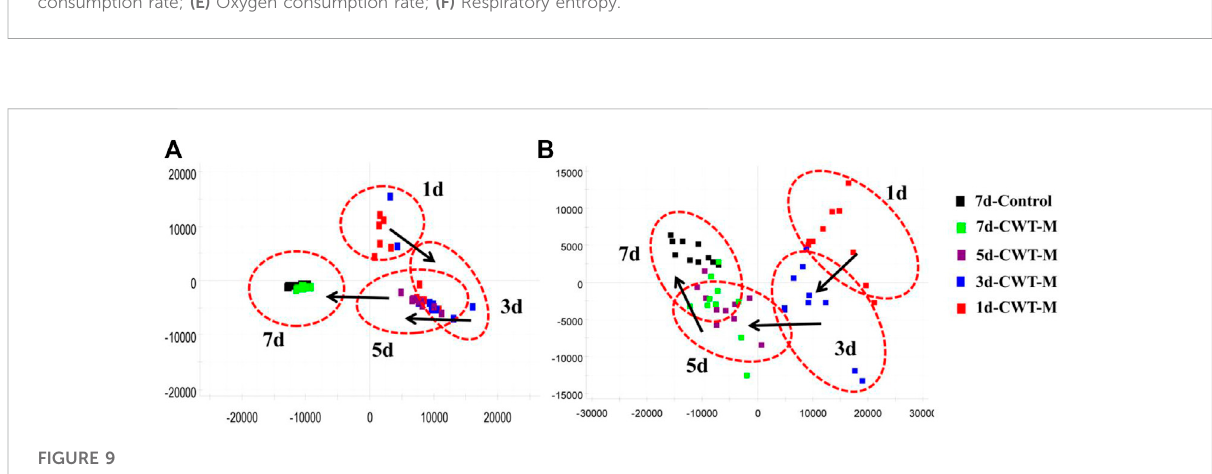
FIGURE 8 Basic metabolic evaluation of rats in each group on Day 7 of treatment (C, control group, n = 10; M, model group, n = 10; DG, diazepam treatment group, n = 10; CWT-M group, n = 10). (A) Food intake of rats in each group; (B) Water consumption; (C) Water exhalation rate; (D) Energy consumption rate; (E) Oxygen consumption rate; (F) Respiratory